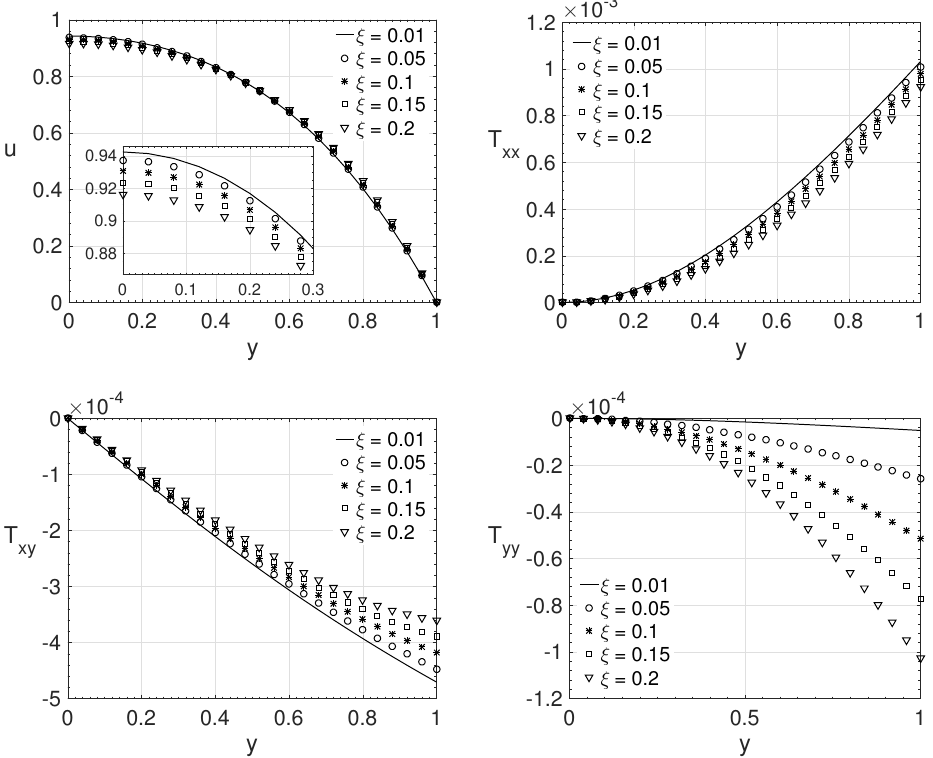
Figure 7. ξ influence on the wall-normal variation y of the streamwise velocity component u and the extra-stress tensor components T xx , T xy and T yy . Dimensionless parameters: Re = 2000, β = 0.125, (cid:101) = 0.5 and Wi =